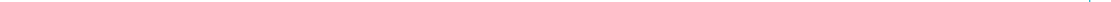
Figure 3: Patient 1, PET/CT, ultrasound and temporal artery biopsy.Sagittal (a) and axial (b) PET/CT fusion with visually positive tracer uptake (arrows) and a SUV ratio of 1.7 in the frontal branch of the left temporal artery of patient 1. Ultrasound reveals an incompressible thickened vessel wall during compression (d, black arrow), compared to before compression (c, white arrow). Lymphohistiocytic infiltrates in the media and the adventitia and severe intimal fibrosis on H and E staining (e, 100×). Histiocytes and giant cells (arrow) are present along the fragment- ed, discoloured internal elastic lamina. Van Gieson elastic stain (f, 200×) with only small residual fragments of the internal elastic lamina (ar- rows). Fibrosis of the intima (lower left) and media (upper